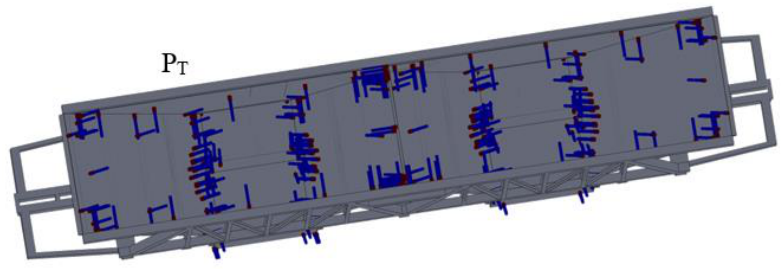
Figure 9. Scheme of application of temperature load to the hopper-wagon-supporting structure.